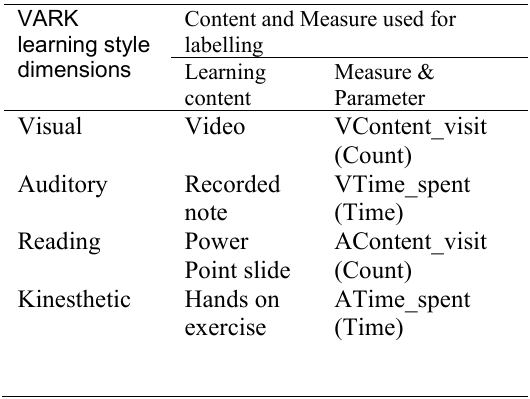
Table 5. Results of performance of CNN with